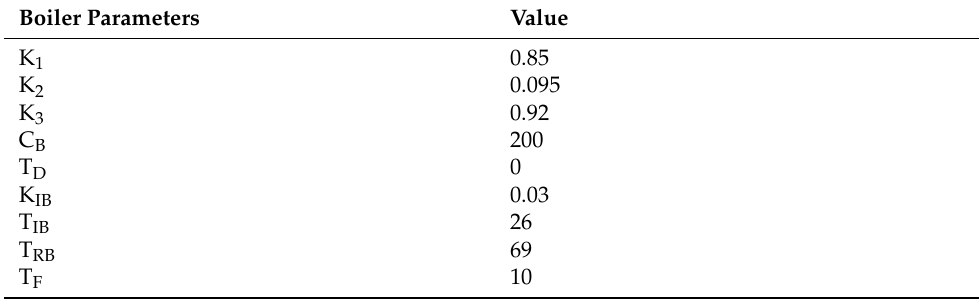
Table A2. The parameters of the steam boiler for the power